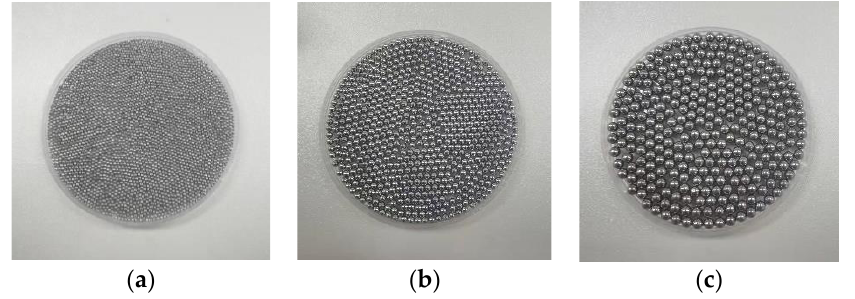
Figure 12. Filling materials of three kinds of particle size. ( a ) 1mm; ( b ) 2mm; ( c ) 3mm.